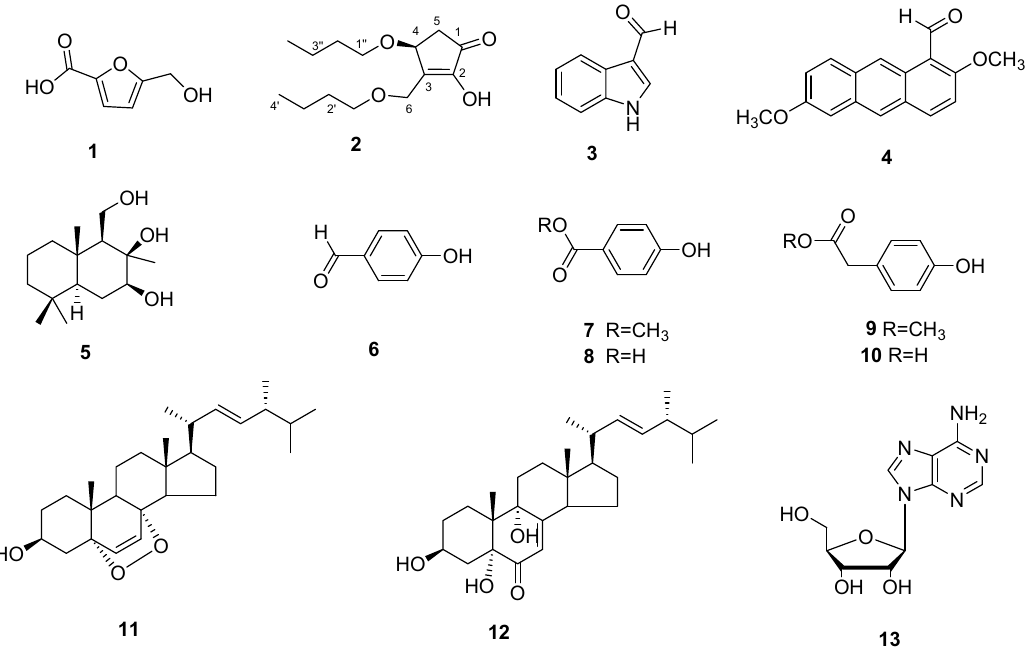
S -hydroxy-3-methyl-cyclopent-2-enone, [ α ] , + 3.36, c 0.375, CH 2 Cl 2 ; 4 R -hydroxy- D 3-methyl-cyclopent-2-enone, [ α ] , - 4.7, c 0.35, CH 2 Cl 2 ) [25]. Therefore, compound 2 was D Figure 4. The Metabolites isolated from D. coniospora YMF1.01759. Figure 4. The Metabolites isolated from D. coniospora YMF1.01759. determined as 4( S )-butoxy-3-(butoxymethyl)-2-hydroxycyclopent- 2-en-1-one (Figure 4). This is a new compound.